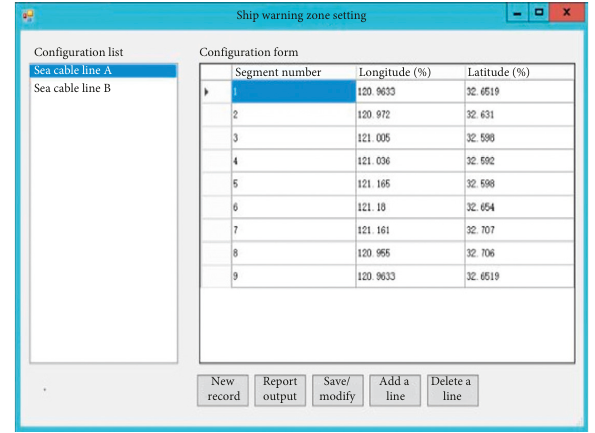
Figure 13: Ship warning zone setting interface.